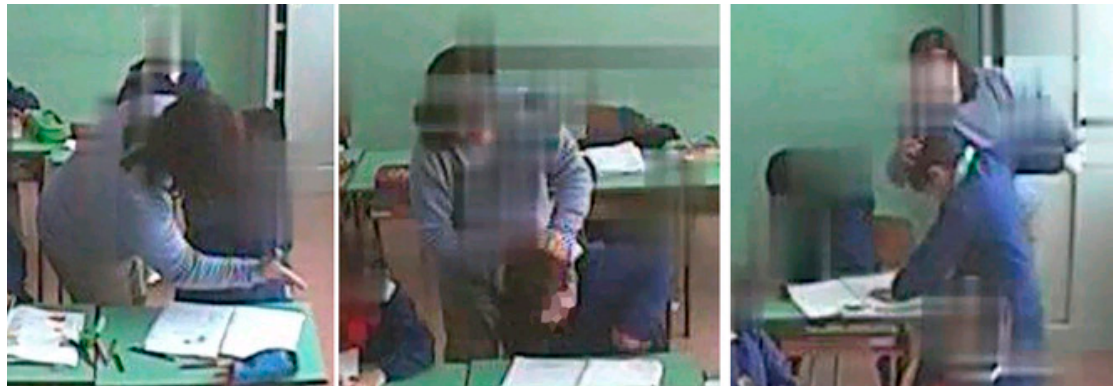
Figure 5. “I’ll bash your face in” and then a beating: this is one of the fragments of a recording in a primary school where the Carabinieri discovered the abuse of the pupils by two teachers. From the on line daily newspaper Il Mattino from Naples, 23 May 2014. http://ilmattino.it/salerno/violenze_